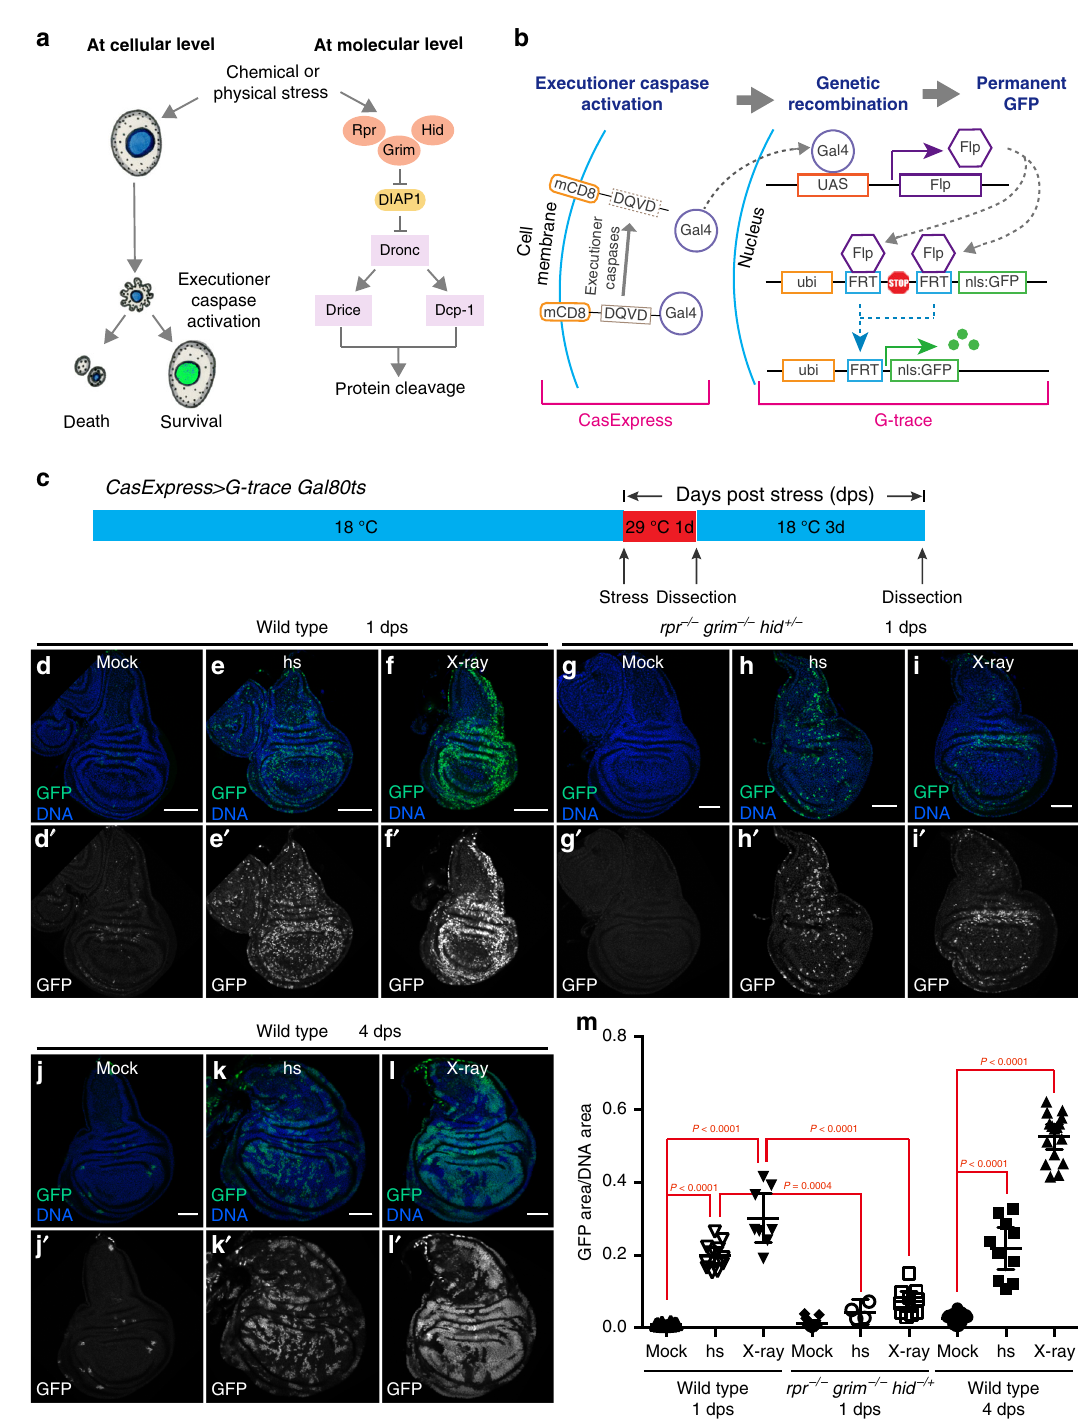
Fig. 1 Survival from executioner caspase activation contributes to regeneration after heat shock or X-ray irradiation. ( a ) A schematic representation of cellular and molecular events in cells that experience stress-induced executioner caspase activation. ( b ) A schematic of CasExpress and G-trace. ( c ) A schematic of the experimental design for results shown in ( d – m ). ( d – f ) CasExpress activation (GFP) in wild type wing discs after mock treatment ( d ), heat shock (hs) ( e ), or radiation (X-ray) ( f ) and 1d at 29 °C. ( g – i ) CasExpress activation (GFP) in rpr − / − grim − / − hid − / + wing discs after mock treatment ( g ), heat shock ( h ), or radiation ( i ) and 1d at 29 °C. ( j – l ) CasExpress activation (GFP) in wild type wing discs after mock treatment ( j ), heat shock ( k ), or radiation ( l ), 1d at 29 °C, and 3d at 18 °C. All scale bars represent 50 μ m. ( m ) Quanti fi cation of the percentage of GFP + cells in discs in ( d - l ). n = 12 (wild type 1dps mock), 12 (wild type 1dps hs), 8 (wild type 1dps X-ray), 11 ( rpr − / − grim − / − hid − / + 1dps mock), 4 ( rpr − / − grim − / − hid − / + 1dps hs), 10 ( rpr − / − grim − / − hid − / + 1dps X-ray), 13 (wild type 4dps mock), 10 (wild type 4dps hs), 16 (wild type 4dps X-ray). n is the number of biological independent samples used for quanti fi cation. The data are presented as mean values ± 95% con fi dence interval. Statistical signi fi cance was determined after the logarithm transformation using one-way ANOVA. The Tukey test was used to derive adjusted P -value for multiple comparisons. Source data are provided as a Source Data fi